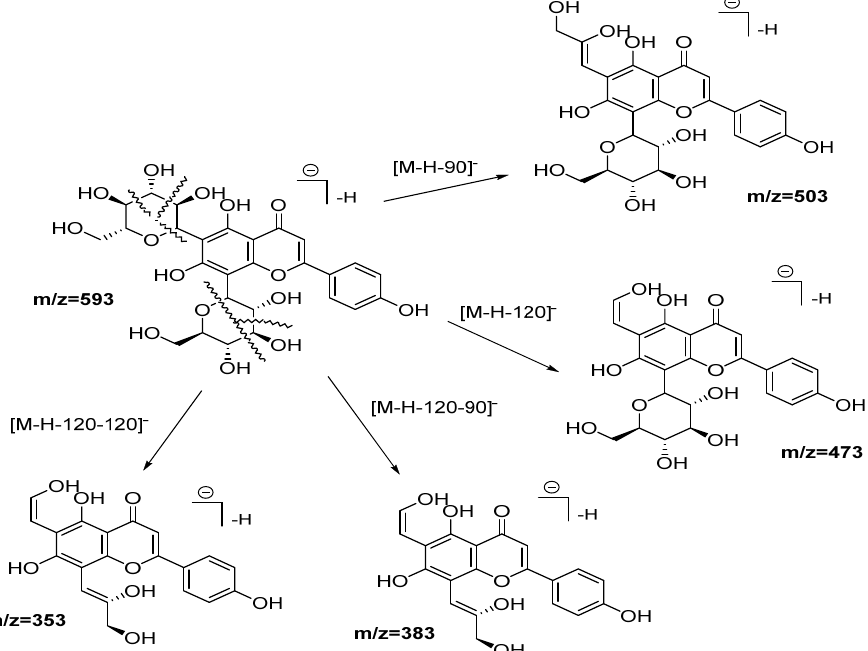
Figure 3. Fragmentation pathways (ESI negative mode) proposed for Vicenin 2.